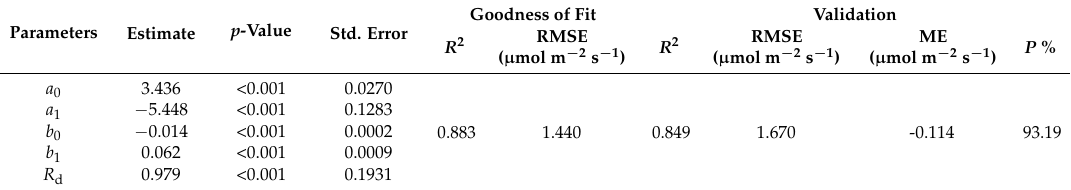
Table 3. Parameter estimates for the crown photosynthetic light-response (PLR) curves model of planted Larix olgensis trees and the goodness of fit statistics. p -value: the level of significance for the parameter estimations, Std. error: standard error for the parameter estimations, R 2 : coefficient of determination, RMSE: root mean square error, ME: mean error, P : precision estimation.